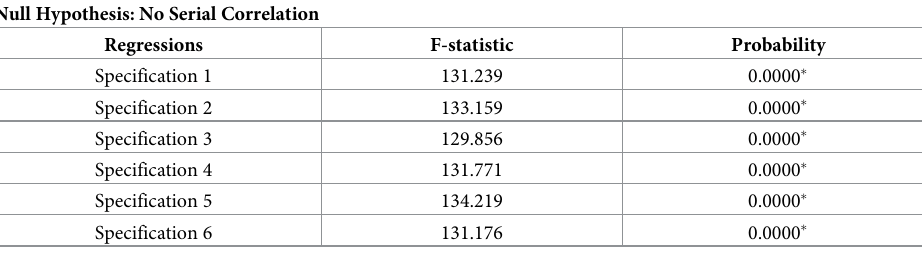
� and �� show significance levels at 1% and 5%, respectively.